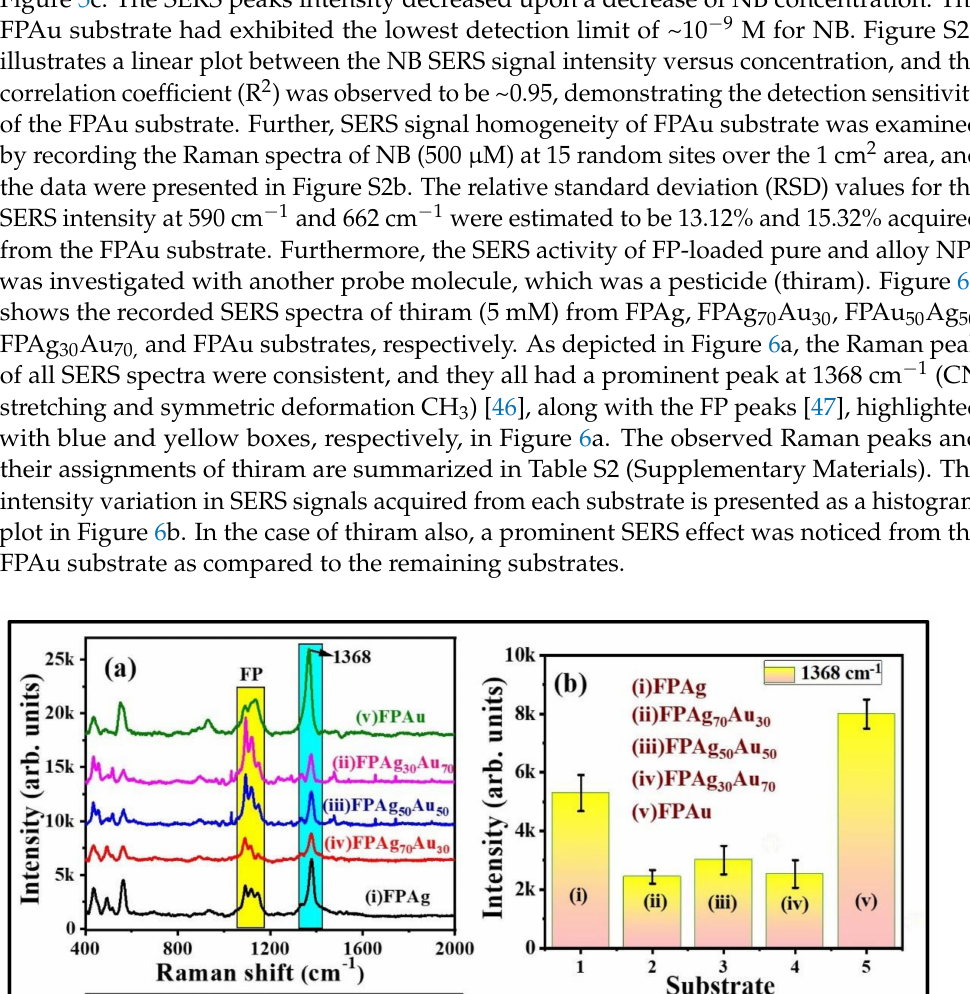
Figure 6. ( a ) SERS spectra of thiram (5 mM) collected from (i) FPAg (ii) FPAg 70 Au 30 (iii) FPAg 50 Au 50 (iv) FPAg 30 Au 70 (v) FPAu substrates. ( b ) Histogram plot of SERS signal intensity at 1368 cm − 1 peak recorded on each substrate. Integration time is 15 s. Errors bars were achieved by estimating the standard deviation of 1368 cm − 1 peak SERS average intensity obtained from five repetitive SERS measurements on each substrate. ( c ) SERS signals of thiram at different concentrations (from 5 mM to 50 nM). ( d ) 3D SERS spectra of thiram (5 mM) collected from randomly selected 10 sites on FPAu substrate. Integration time was 15